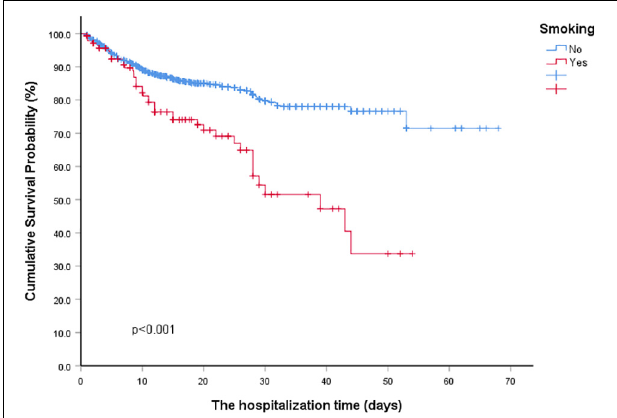
FIGURE 1 | Kaplan-Meier survival curves for COVID-19 patients with and without Smoking history. * P < 0.01 for smoking group vs. non-smoking group.